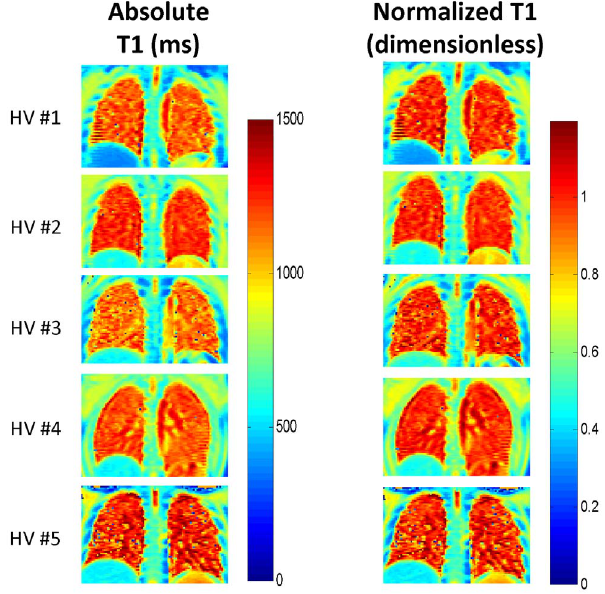
Figure 2. Absolute and Normalized T1 Maps from Healthy Volunteers. Absolute (left column) and normalized (right column) T1 maps from each of five healthy non-CF control subjects. The absolute T1 maps exhibited visible subject-to-subject variation despite the absence of known lung disease. The normalized T1 maps were generated directly from the absolute T1 maps by dividing by the mean central T1 relaxation time for each subject and resulted in reduced subject-to-subject variation for the healthy control subjects. HV: healthy volunteer.